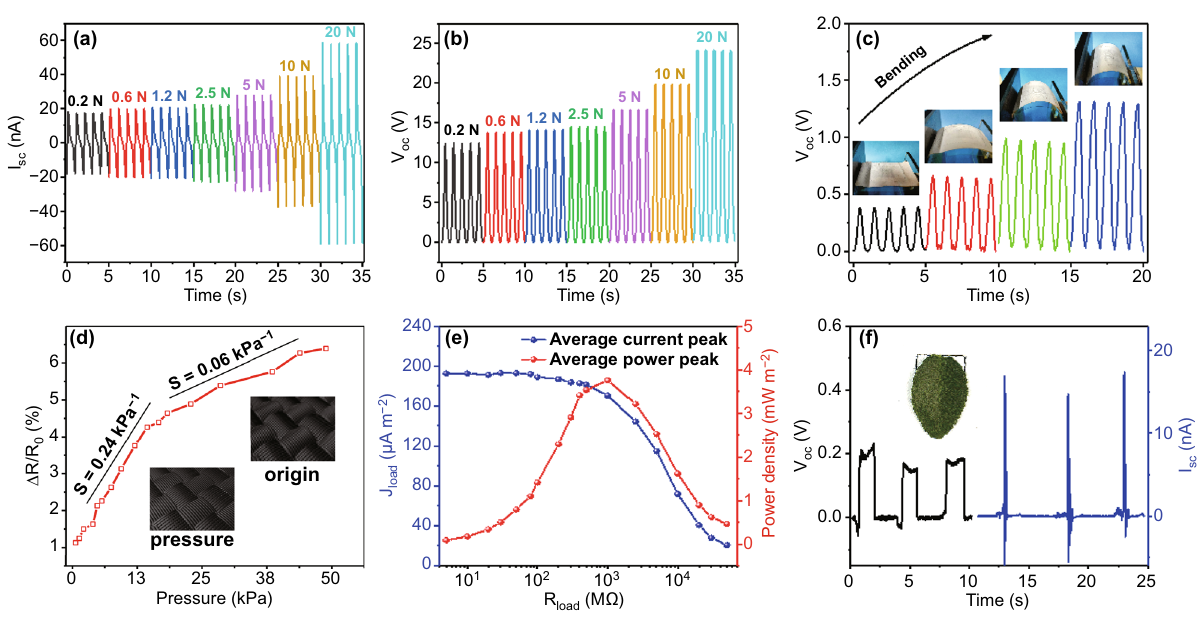
Fig. 3 Pressure response of the F-TENG. a‑b Electrical output of the F-TENG under different loading forces. c Effect of the degree of curvature on the V oc of the F-TENG. The insets are the photographs of different bending states of the F-TENG. d Variation of resistance at different pres- sures. The insets are the schematic diagrams of the CNT/Cotton fabric under cycling loading and unloading pressure. e Instantaneous current density and power density varying with external resistance. f Optical image and electrical output of the F-TENG loading by a small